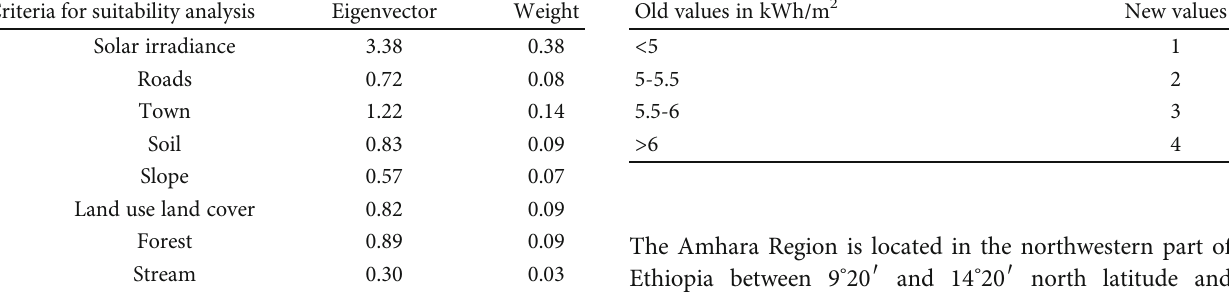
Table 6: Eigenvector and weights of the criteria solar attributes. Criteria for suitability analysis